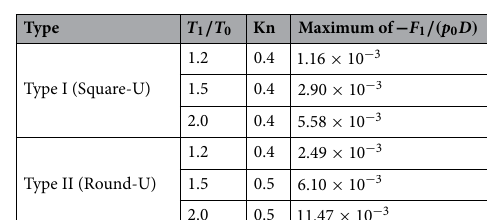
1.2 , 1.5, and 2 in the case of H / D =